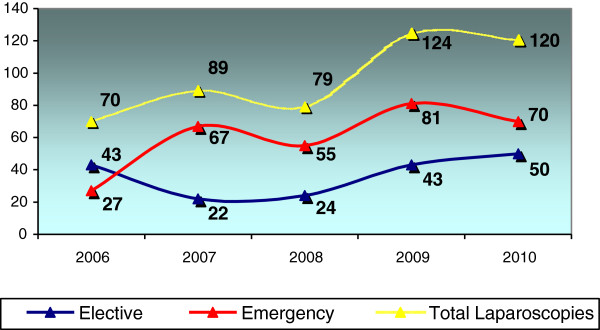
Numbers of pediatric laparoscopic surgical procedures performed annually at our institution over the 5-year period from January 2006 to December 2010. The proportions of emergency and elective procedures are shown.